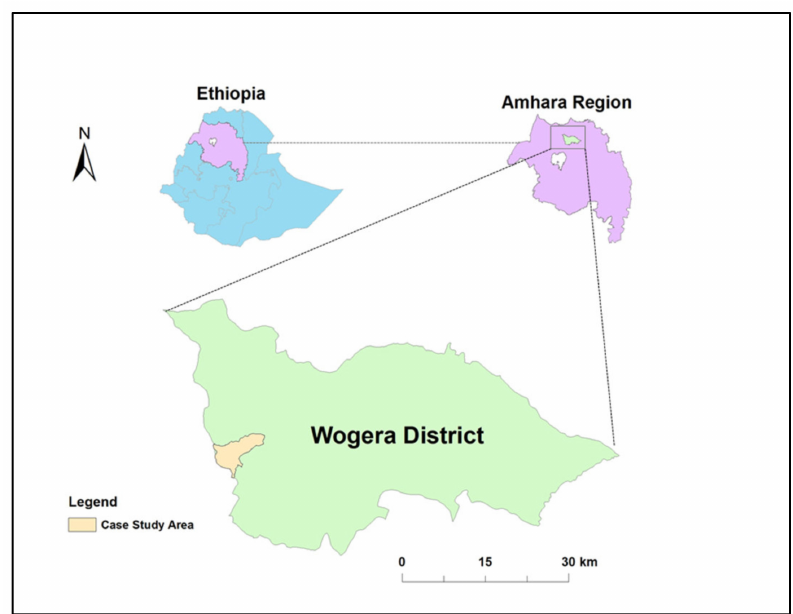
Figure 1. Location map of the case study area in Wogera district, Northern